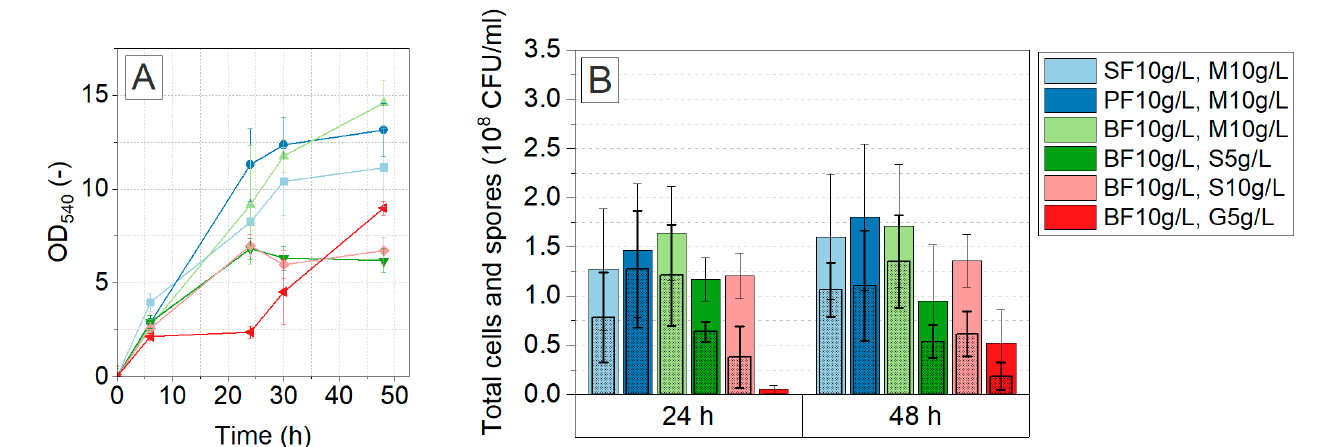
Figure 1. B. subtilis MSCL 897 cultivation in medium containing combinations of soybean (SF), broad bean (BF) and gray pea (PF) flour, sucrose (S), glucose (G) and molasses (M): ( A ) the optical density (OD) dynamics over time; ( B ) total cell (outer bars) and spore (inner bars) counts at 24 and 48 h. Legend colors correspond to both plots.